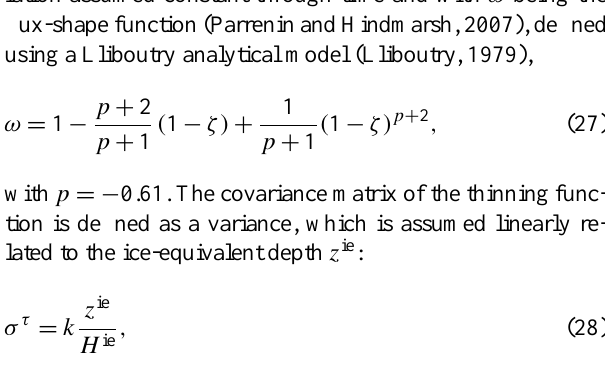
fit with the layer-counted GICC05 (Svensson et al., 2008) age markers sampled every 5 kyr along the